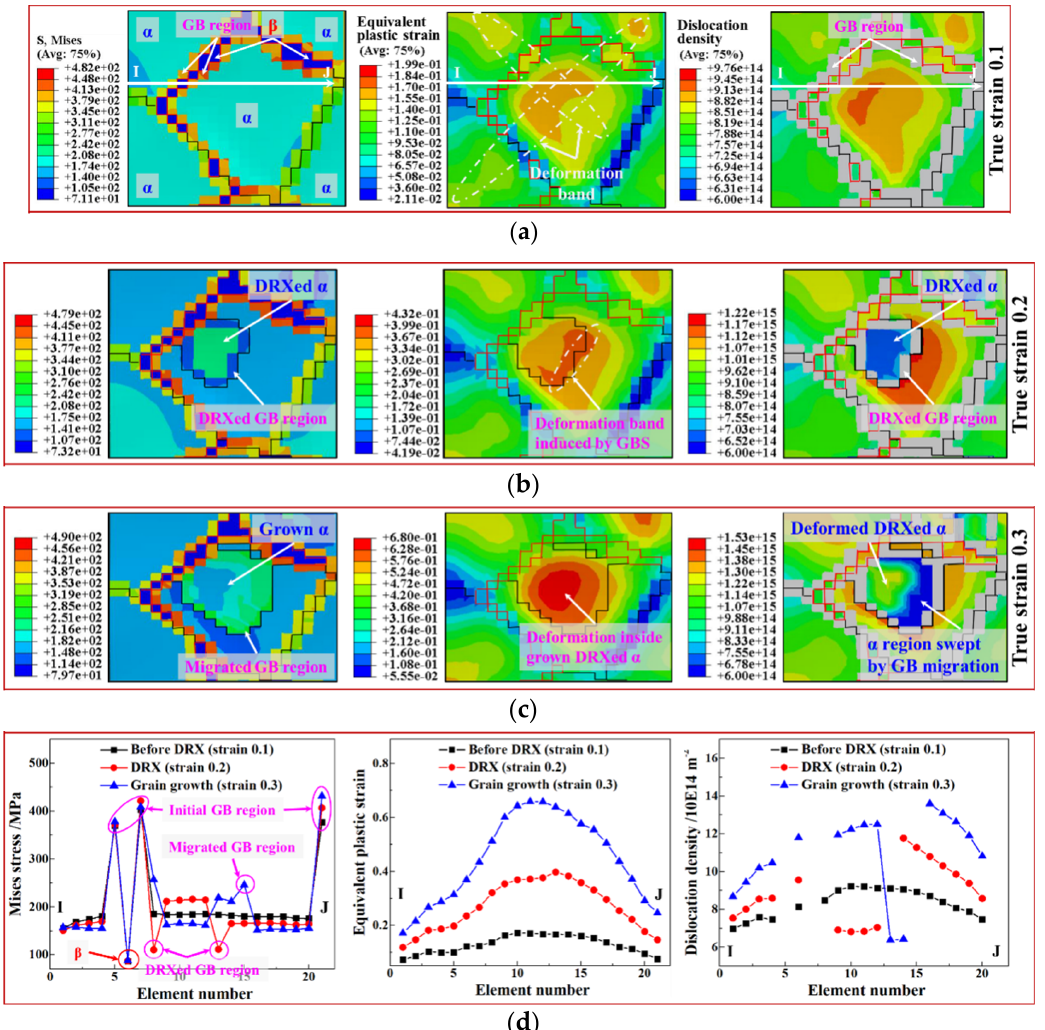
Figure 11. Simulated distribution of stress, strain and dislocation density of DRX in the white dashed box in the Figure 9a (800 °C–0.001 s − 1 ). ( a ) True strain of 0.1; ( b ) true strain of 0.2; ( c ) true strain of 0.3; ( d ) line chart of stress, strain and dislocation density under different DRXed stages.